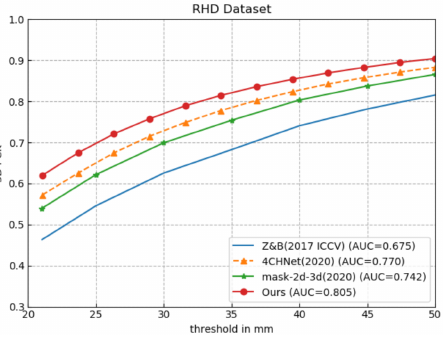
Figure 8. Comparison with the state-of-the-art methods on Rendered Hand Pose (RHD) dataset